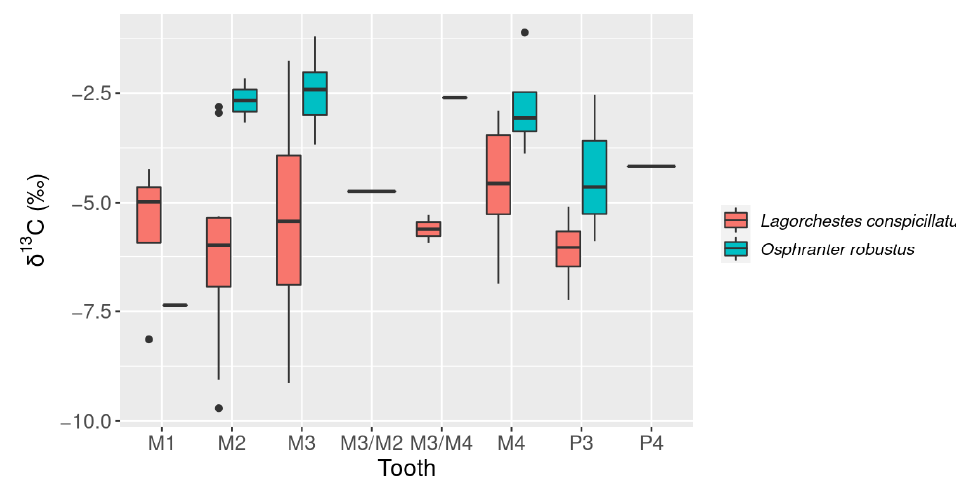
Figure 6. Box plot L. conspicillatus and O. robustus δ 13 C by tooth (M = molar, P = premolar). Stratigraphic units, and corresponding chronological, paleoenvironmental and ar- cheological contexts for Boodie Cave are documented in recent syntheses and summa- rized in Table 2 [4,5,27]. Comparison did not identify a statistically discernible separation between the archaeological and modern teeth in this study (Figure 7). Equally, no signifi- cant inter-strata differences were identified. This is true even when a −1.2‰ correction is added to the archaeological specimens to account for depletion in modern δ 13 C resulting from burning of fossil fuels [28,29]. While no statistically significant differences were de- tected between stratigraphic units, δ 13 C associated with the islandization phase trended more negative than signals recorded in layers linked to regression of the shoreline with falling sea levels.